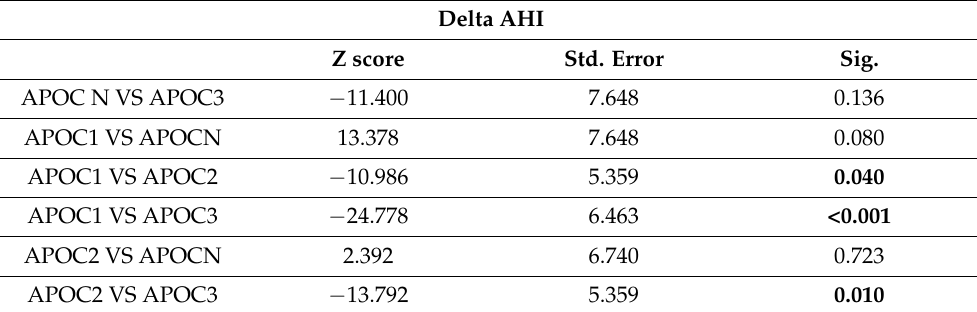
Table 3. Kruskal–Wallis test comparing delta AHI, delta AHI supine, and delta AHI non supine in APOC groups (APOC N stands for non-classifiable APOC). Delta AHI Std.